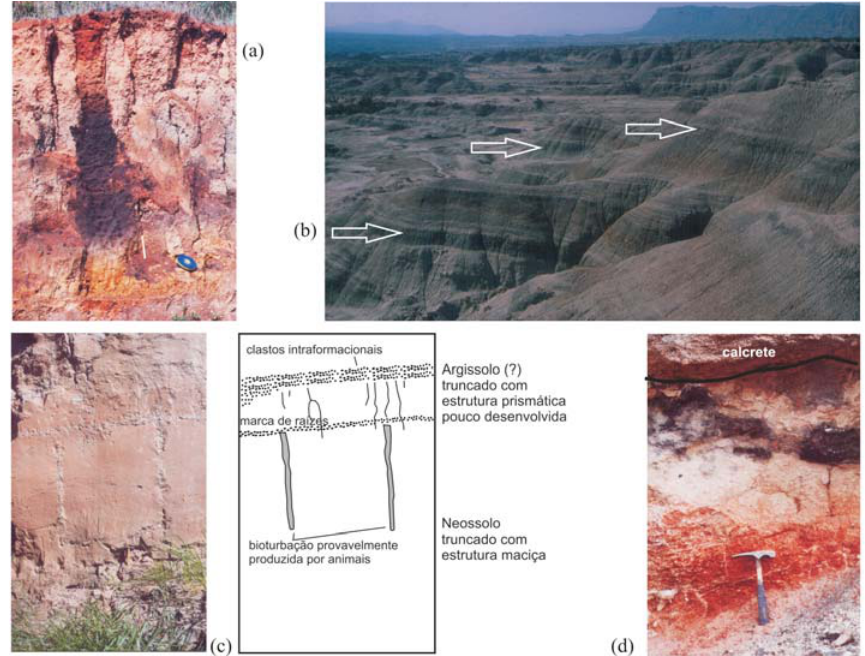
Figura 5. (a) Horizonte orgânico enterrado na Serra da Mantiqueira (Minas Gerais), datado com 14 C em 30.070 anos; (b) Horizontes orgânicos (indicados pelas setas) na Formação Ischigualasto (Triássico, Província de San Juan, Argentina); (c) Horizontes truncados na Formação Marília (Cretáceo, Echaporã, SP); (d) Horizontes pedológicos na Formação Los Llanos (Cretáceo, Província de La Rioja, Argentina). Na porção superior da foto há um perfil de calcrete que apresenta um ninhal de